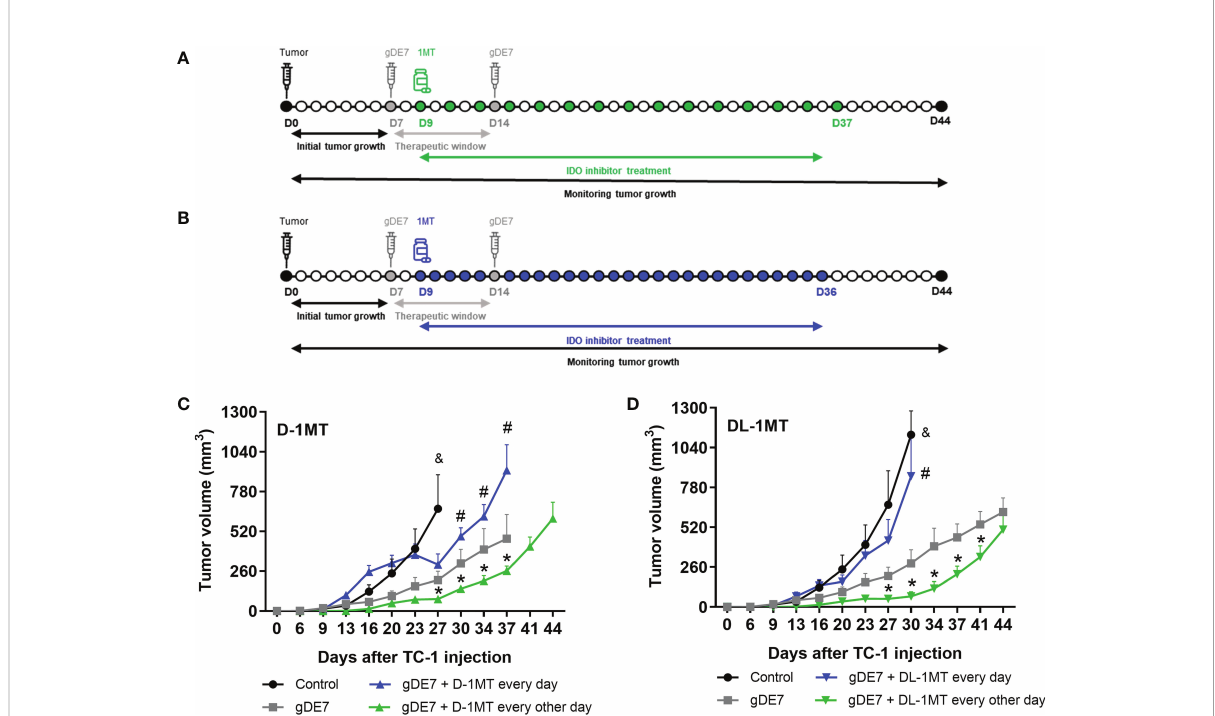
FIGURE 1 The administration regimen of 1MT isoforms affects the therapeutic antitumor effects of gDE7. Female WT mice were inoculated with TC-1 (D0) cells. Seven (D7) and fourteen (D14) days after the tumor engraftment, the animals were immunized with gDE7 (30 m g, subcutaneously). Two days after the fi rst dose (D9), mice were treated with 1MT isoforms (A, B) , either daily with 8mg/animal (A) (n = 10) or 10 mg/animal every other day (B) (n = 10) for four weeks, until day 36 (D36) or day 37 (D37), respectively. The experimental groups were followed for 60 days. Tumor volumes were followed up to 44 days in mice treated with the different treatments using (C) D-1MT or (D) DL-1MT. The tumor growth “ endpoint data ” for each group was plotted up to the date when at least 80% of the mice were alive. The data represent the average of two independent experiments and were analyzed by ANOVA. (&) p <0.05, statistical signi fi cance of control group concerning all the others; (#) p <0.05, statistical signi fi cance of gDE7 + 1MT every day group concerning all the others; (*) p <0.05, statistical signi fi cance of gDE7 + 1MT every other day group concerning all the others. The results were con fi rmed through multiple comparisons by Turkey ’ s test (three or four groups) or Sidak ’ s test (two groups), comparing each group mean with the other group mean at the same time point. D0 - day zero; D7 - day 7; D9 -